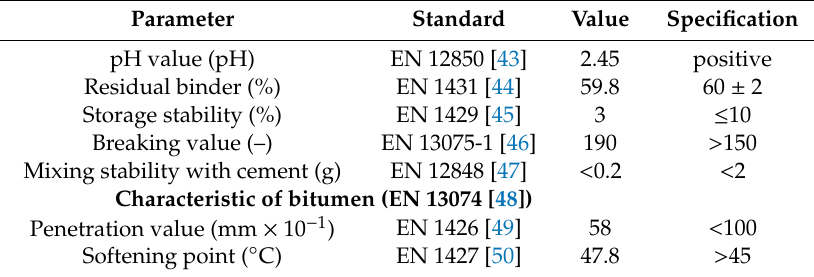
Table 5. Bituminous emulsion